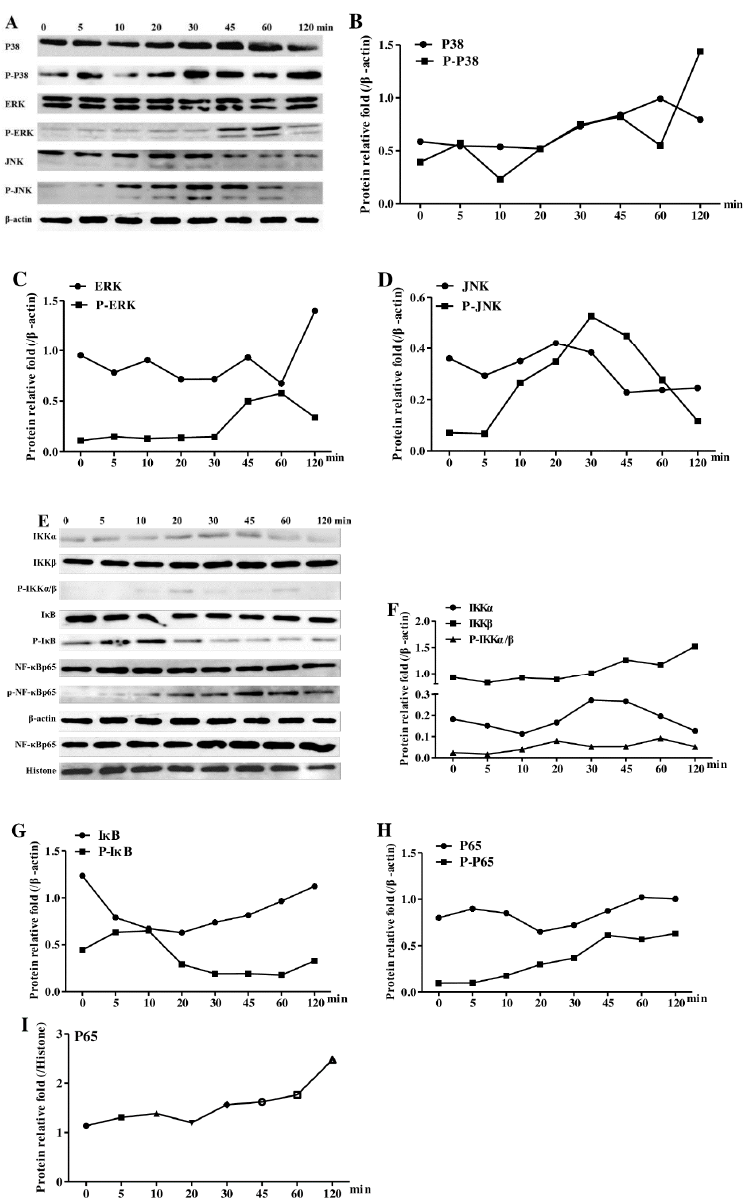
Figure 9. E ff ect of AEAR on MAPK and NF- κ B signaling pathway in DCs. Immature DCs treated with AEAR for di ff erent periods. DCs proteins were extracted with a nuclear and cytoplasmic extraction kit. ( A ) P38, JNK, ERK, and their corresponding phosphorylated proteins were detected by Western blotting with specific antibodies. ( B – D ) The quantitative analysis of P-P38 / P38, P-ERK / ERK, and P-JNK / JNK protein levels; ( E ) IKK α , IKK β , I κ B, NF- κ B p65, and their corresponding phosphorylated proteins in cytoplasm and NF- κ B in nucleus were determined by Western blotting. ( F – H ) The quantitative analysis of IKK α , IKK β , P-IKK α / β , I κ B, P-I κ B, P65, and P-P65 protein levels. Values were normalized to the level of β -actin; ( I ) quantitative analysis of nuclear P65 protein level, values were normalized to the level of histone. The anti-actin antibody and anti-histone antibody were used as the control